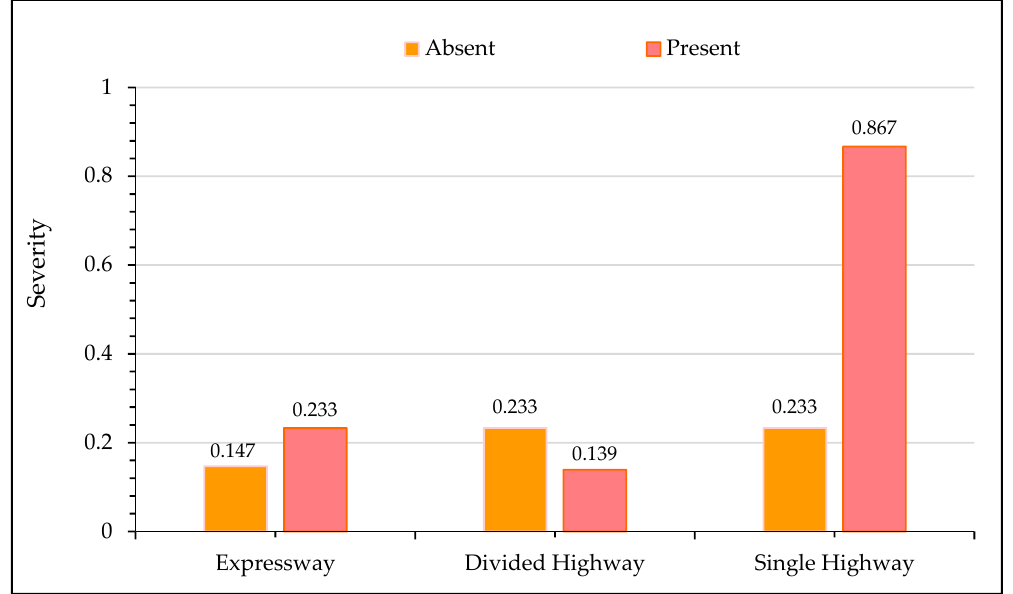
Figure 3. Effect of highway type on crash severity. Figure 3. E ff ect of highway type on crash